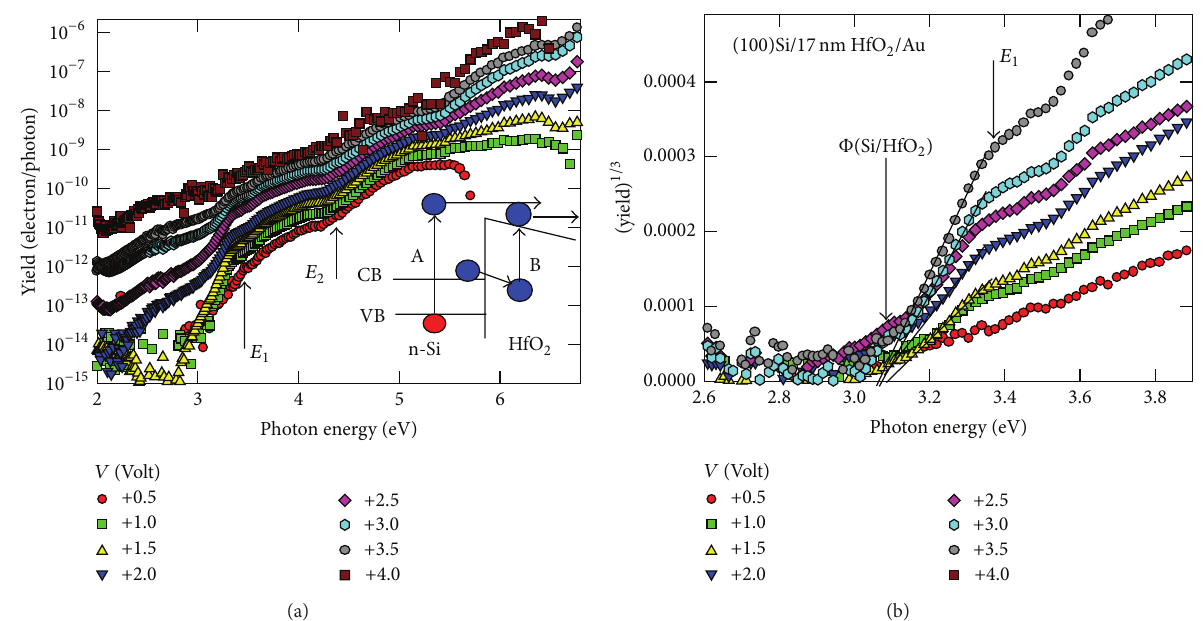
Figure 9: (a) Semilogarithmic plot of the IPE quantum yield as a function of photon energy measured on n-type (P-doped, 𝑛 𝑑 ≈ (1 – 3) × 10 15 cm −3 ) (100)Si/HfO 2 (17nm)/Au sample with the applied bias varying from 1V to 4 V. The inset illustrates the schematic of the IPE type electron transitions (A) and the transitions associated with photoionization of near-interface oxide traps (“pseudo-IPE”, B). The arrows 𝐸 1 and 𝐸 2 indicate onsets of direct optical transition in the silicon crystal. (b) Cube root of the IPE yield as a function of photon energy as inferred from the data shown in the panel (a) after subtracting the “pseudo-IPE” background photocurrent. The inferred spectral threshold Φ of electron IPE from the VB of Si into the CB of HfO 2 is indicated by the vertical